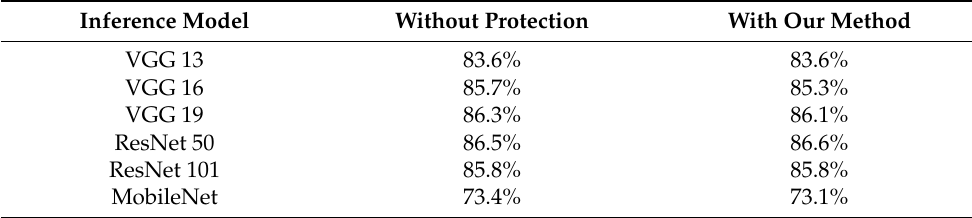
Table 3. Precision quantisation on our